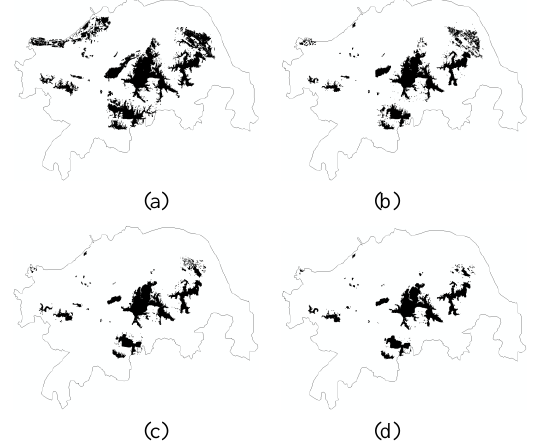
Figure 7. Vector maps of extracted urban lakes in different year: (a) 1991, (b) 2002, (c) 2011, and (d) 2017.